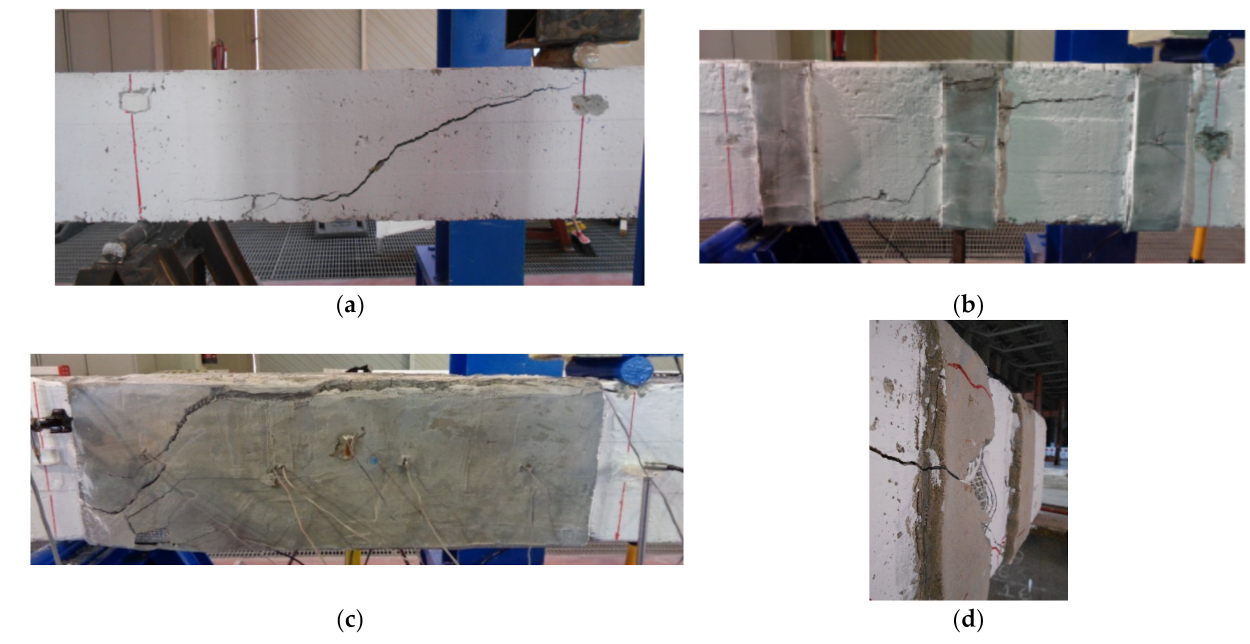
Figure 7. Failure configurations for ( a ) B-Control and ( b ) B-D-1L-3S, B-C-2L; and details of failure configuration for ( c ) B-C-2L and ( d )